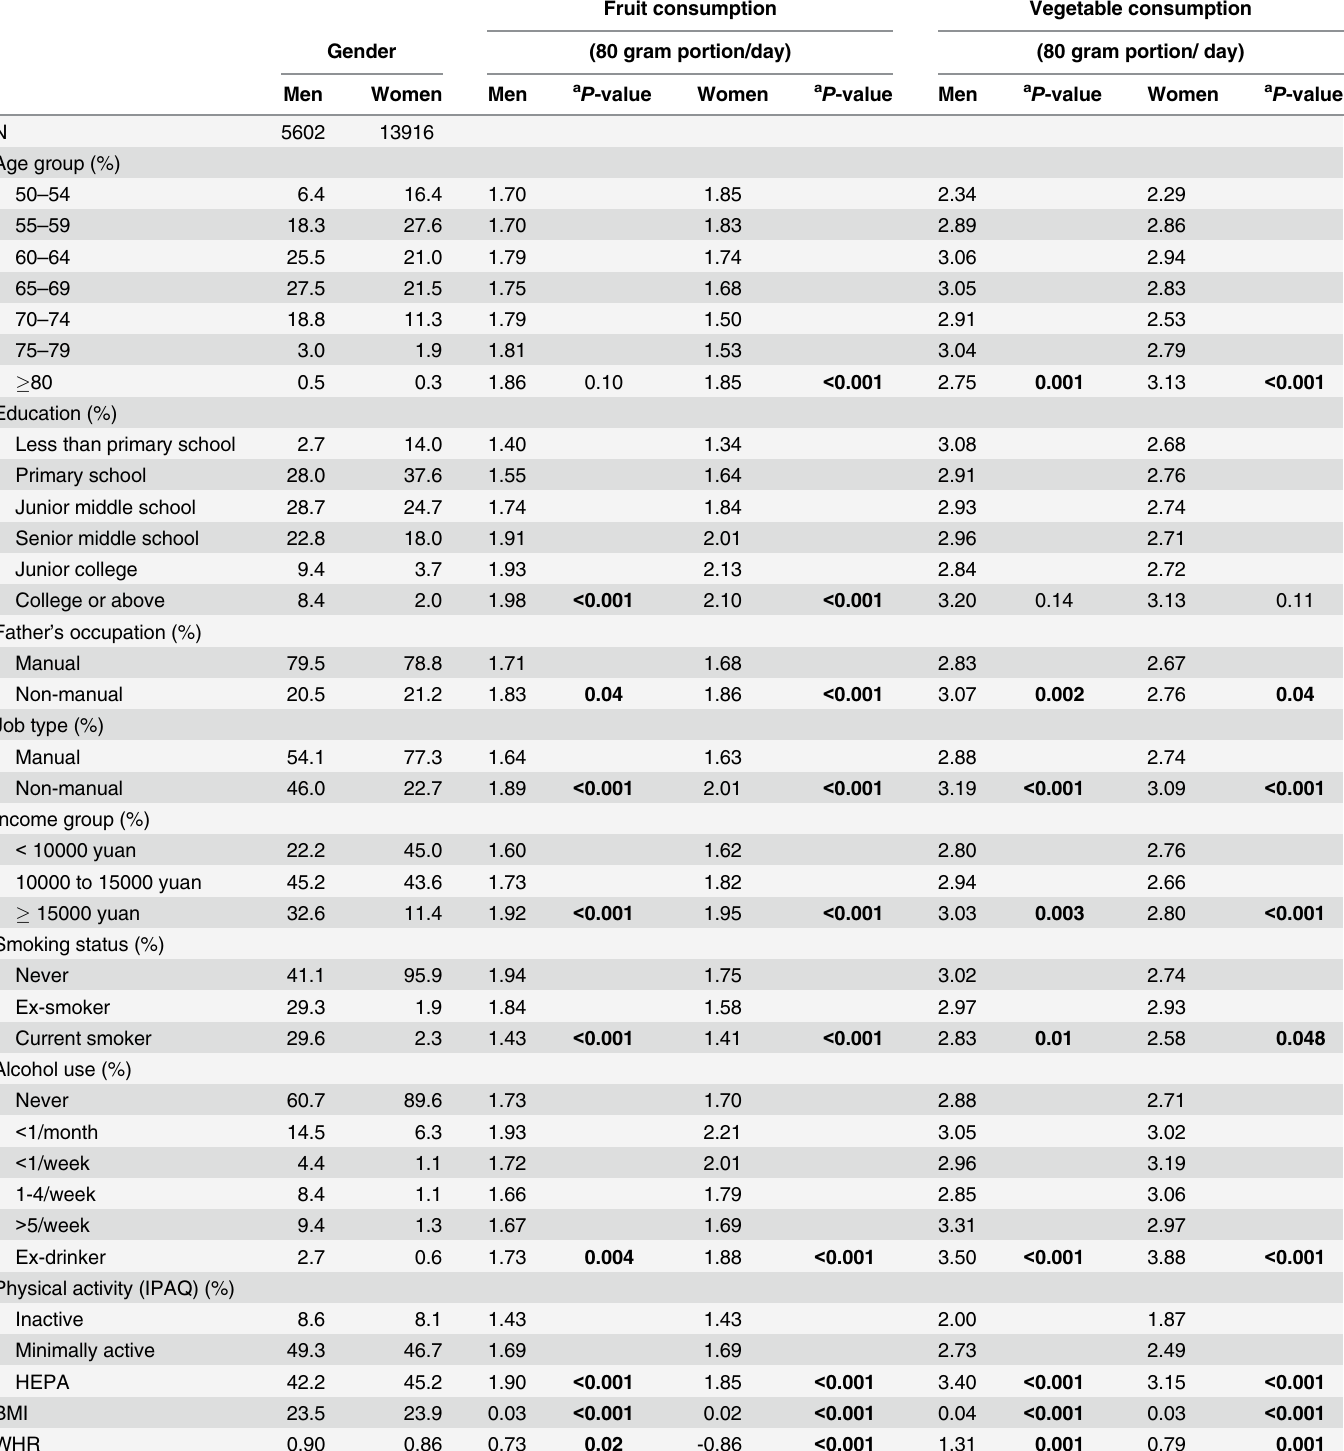
Table 1. Characteristics by Fruit and Vegetable Consumption in Older Chinese (5602 men and 13,916 women) in Phases 1 and 2 of the Guangzhou Biobank Cohort Study, 2003 – 2006. Fruit